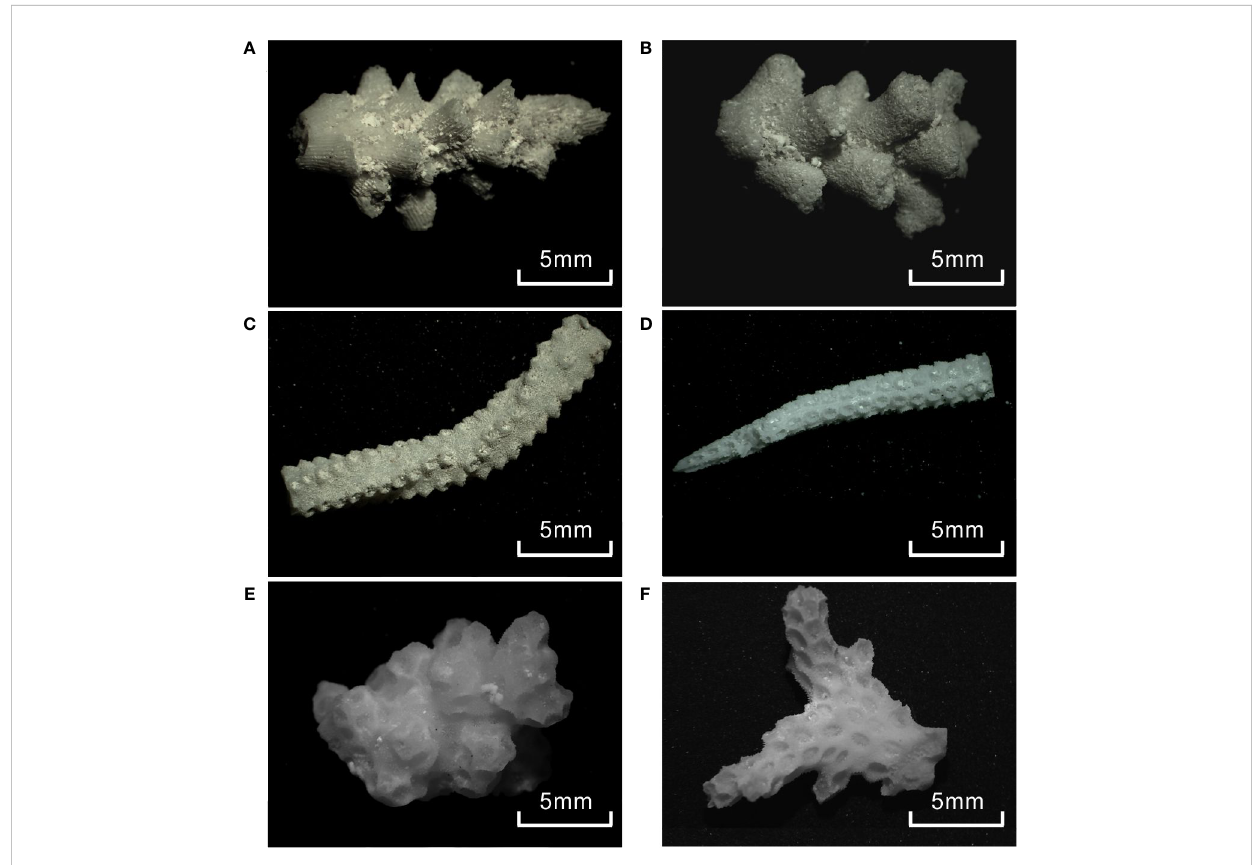
FIGURE 4 Representative photos of subfossil branching coral samples selected from the reef cores: (A, B) Acropora spp.; (C, D) Seriatopora spp.; (E, F) Pocillopora